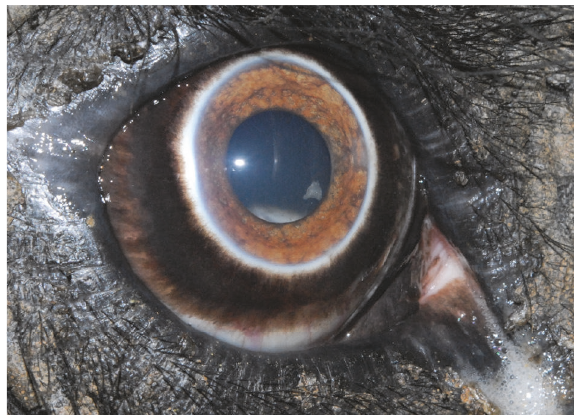
Figure 12: A small piece of what appears to be lens nuclear material can be visualized within the ventromedial pupil at approximately the 4 o’clock position.